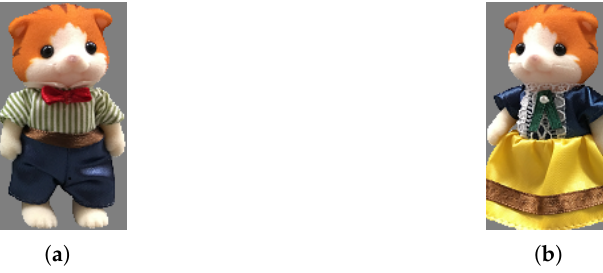
Figure 1. Images 1 and 2 at 173 × 100 pixels. ( a ) Image 1. ( b ) Image 2.